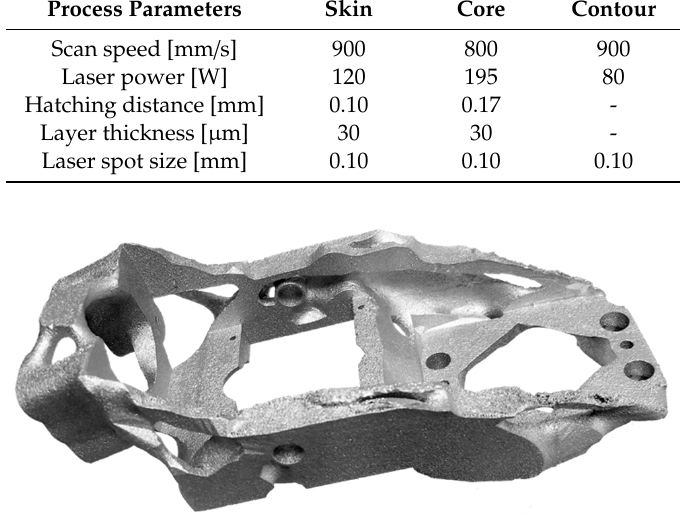
Figure 11. The technical prototype produced by EOSINT M270.